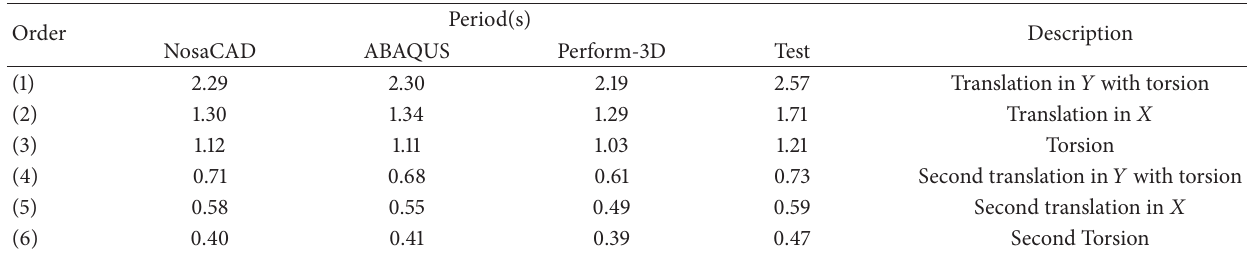
Table 2: Natural vibration periods of the structure.